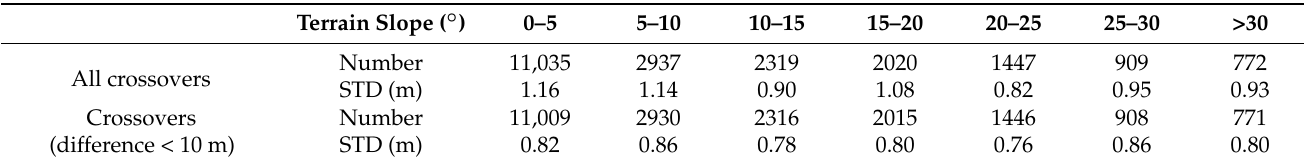
Table 6. Accuracy statistics of crossover difference in different terrain slopes.